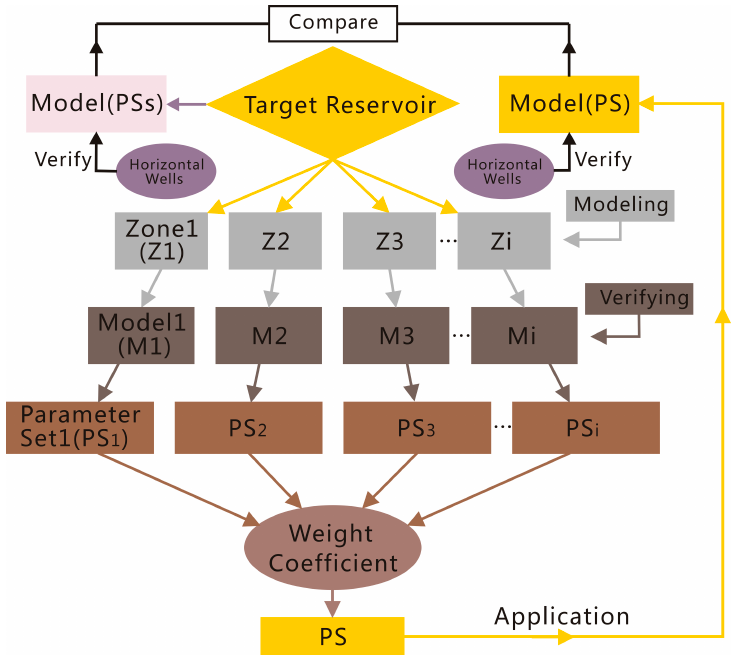
Figure 4. Workflow of the weight coefficient method of modeling sandstone and mudstone distribution.